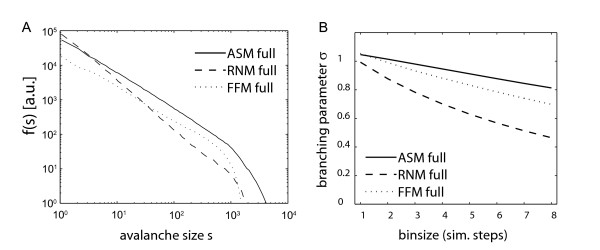
Avalanche distributions and branching parameters for fully sampled model sytems. (A) Avalanche Distributions for the fully sampled SOC models evaluated in logarithmic binning. The avalanche distributions of the fully sampled models do not change with the bin size, due to the infinite separation between subsequent avalanches in the models. All f(s) follow a power law for s < 500. The steeper decay for large s is caused by the finite size of the models. Solid line – Abelian sandpile model (ASM). Dashed line – random neighbour model (RNM). Dotted line – forest fire model (FFM). Avalanche distributions have been set apart for better visibility by multiplication with a constant factor per curve. (B) Dependence of the branching parameter σ on the bin size. Sigma is near unity for small bin sizes. For larger bin sizes sigma decays due to the finite size of the models. Solid line – Abelian sandpile model (ASM). Dashed line – random neighbour model (RNM). Dotted line – forest fire model (FFM). Bin size given in simulation steps.